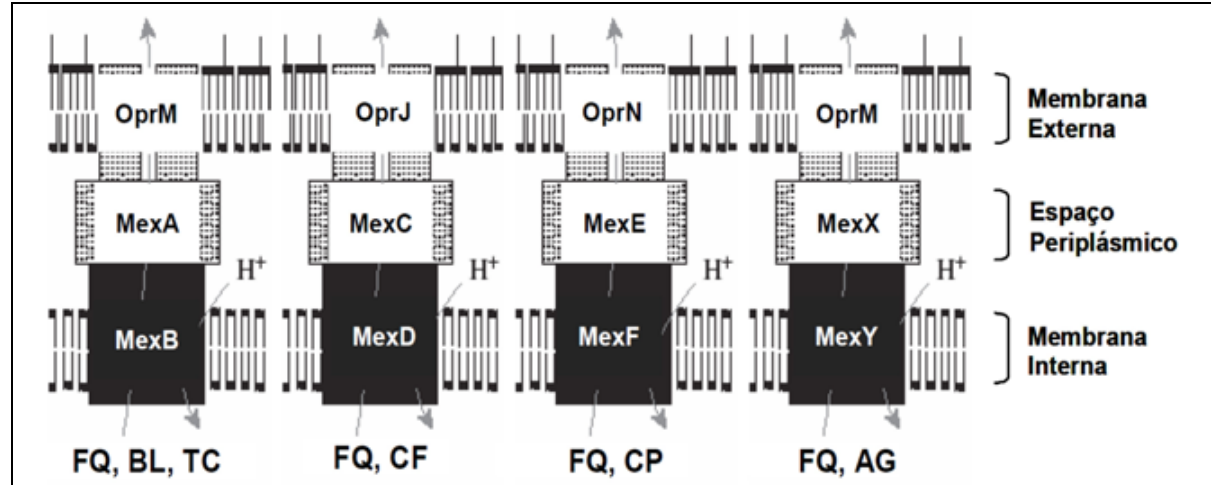
Figura 2 – Modelos estruturais e funcionais das bombas de efluxo de P. aeruginosa , indicando a localização das proteínas constituintes da bomba e ação preferencial a deter- minados tipos de substratos FQ: fluoroquinolona; BL: betalactâmico; TC: tetraciclina; CF: cefalosporina; CP: carbapenêmico; AG: aminoglicosídeo. Adaptada de Aeschlimann (2003) (2) , Neves (2010) (71) e Poole (2005) (86) .